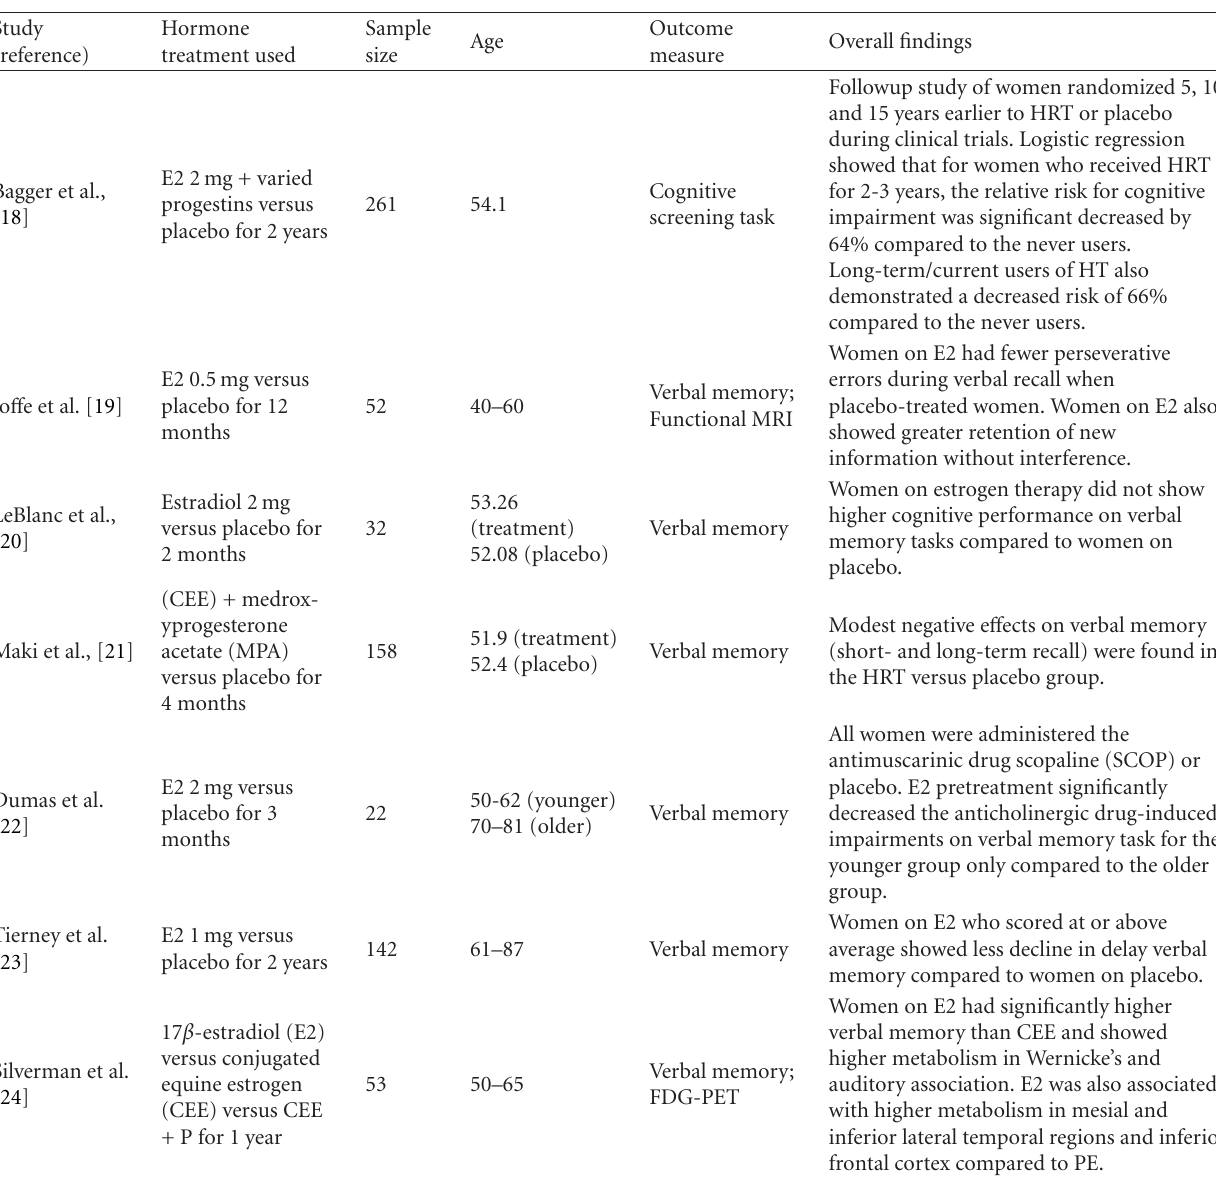
Table 2: Randomized clinical trials of HRT and verbal